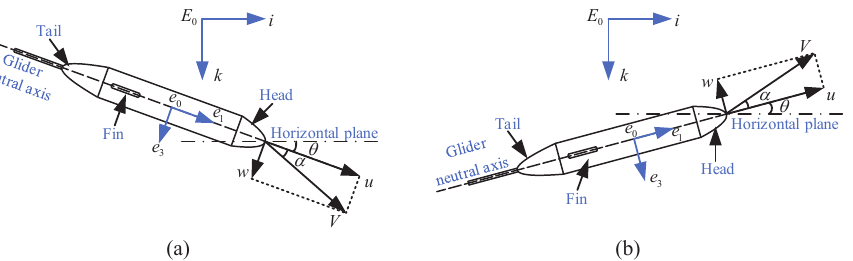
Figure 1. Velocity and pitch angle of underwater gliders in vertical plane. ( a ) Submerging process; ( b ) Floating